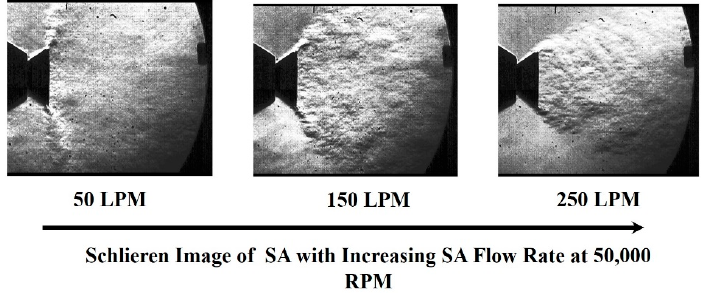
Figure 12. Schlieren Image of the ERBS SA, showing increasing SA flow rate at a fixed of bell cup rotational speed of 50,000 RPM.